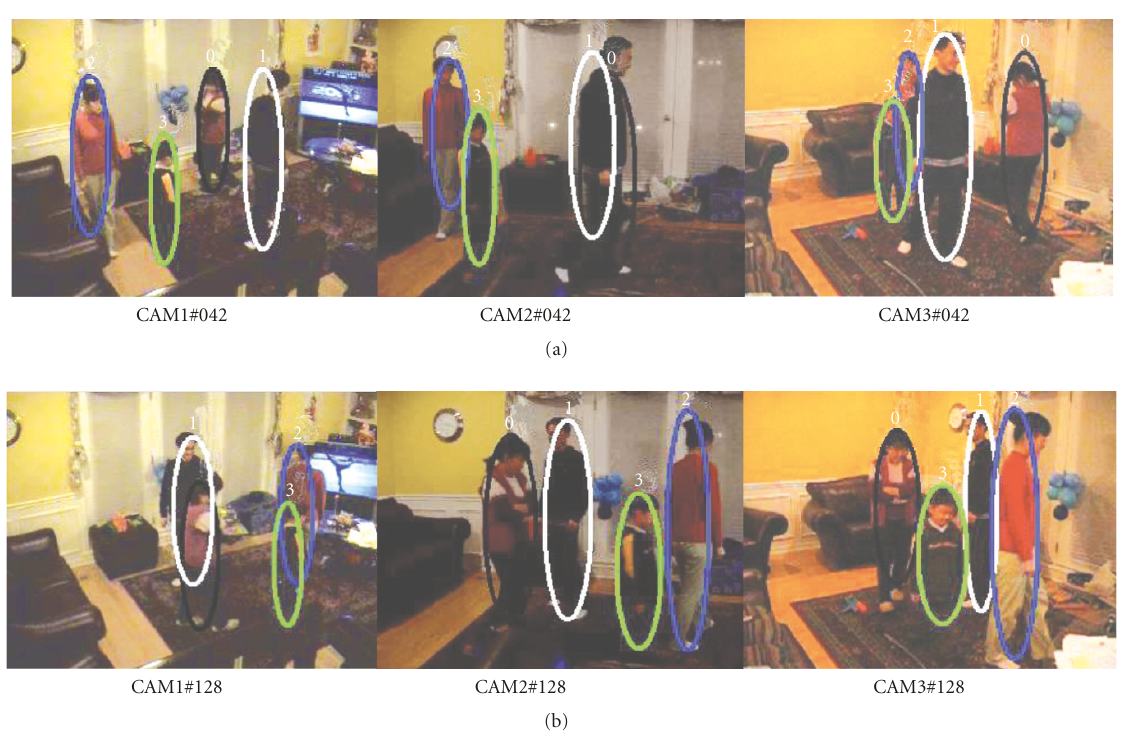
Figure 10: Tracking results of the proposed BMCT on the trinocular videos LivingRoom .